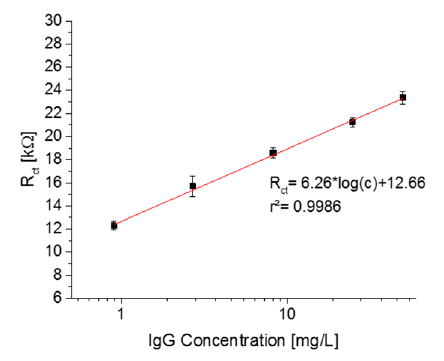
Figure 3. Dependence of charge transfer resistance on IgG concentration; c 0 = 1